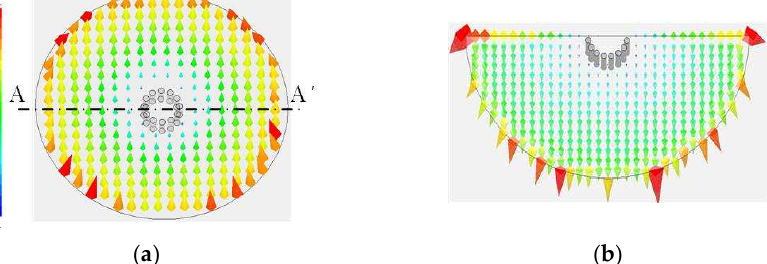
Figure 2. Electric field distributions of the TM010 mode of the two patch resonators. ( a ) Circular patch resonator; ( b ) semicircular patch resonator.